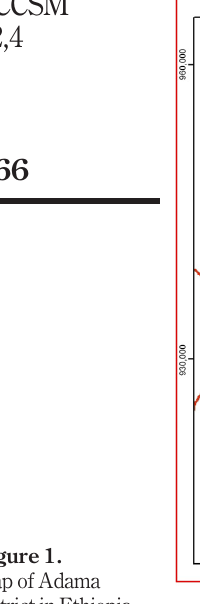
Figure 1. Map of Adama district in